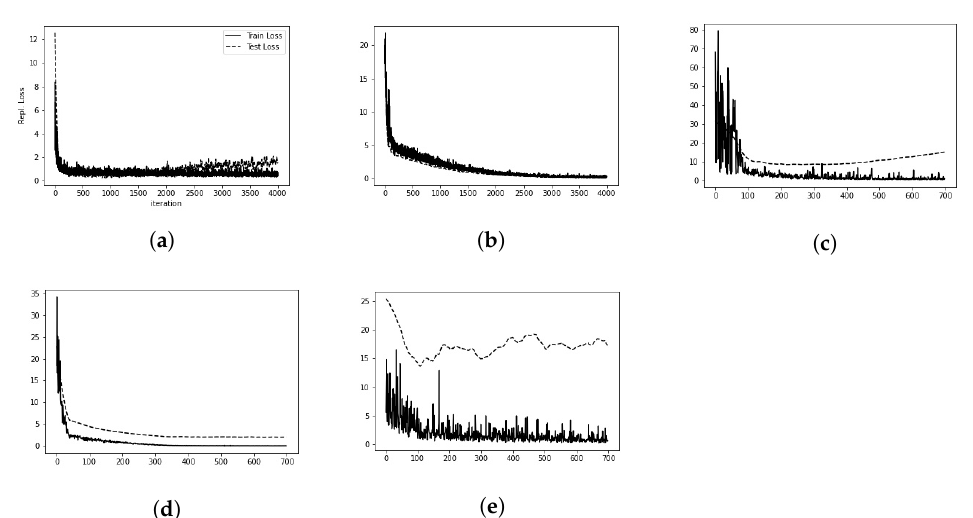
Figure A3. Losses of the deep hedgers training to hedge a spread option between 3MAH Gas and 3MAH Coal. Dashed lines represent test losses computed on the historical time series; plain lines represent generator losses computed on synthetic time series. ( a ) GBM ( b ) CEGEN. ( c ) TSGAN. ( d ) COTGAN. ( e )